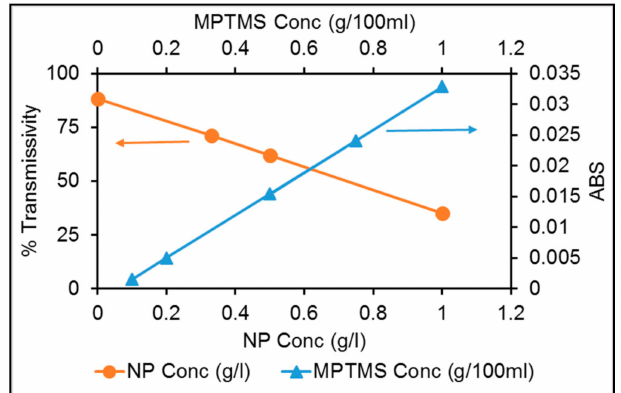
Figure 2. Calibration curves for detecting nanoparticle (NP) concentration and 3-Mercaptopropyl Trimethoxysilane (MPTMS) concentration. ABS: